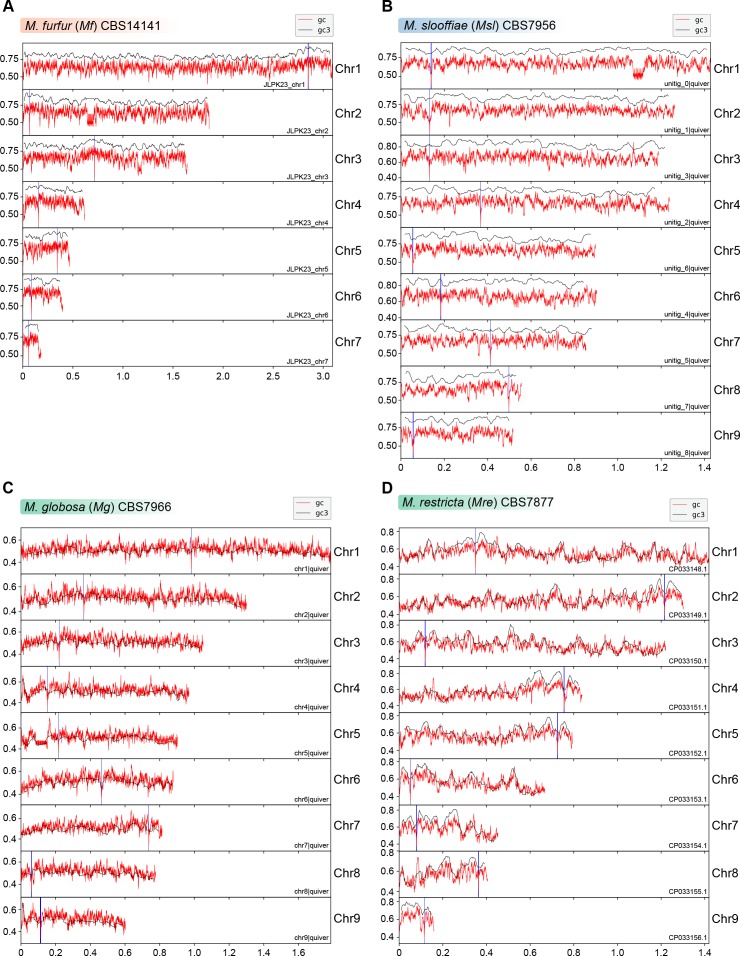
Putative centromeres of M. furfur, M. slooffiae, M. globosa, and M. restricta map to global GC troughs in each chromosome.(A–D) Graphs indicating the GC content (red lines) and GC3 content (black lines) of each chromosome of M. furfur, M. slooffiae, M. globosa, and M. restricta. The GC3 content is measured by estimating the G or C content at the third position in each codon of all genes across a chromosome (Lynch et al., 2010; Zhu et al., 2017). Position of putative centromeres mapping to chromosomal GC minima are marked in blue. The x-axis indicates chromosomal coordinates in Mb.